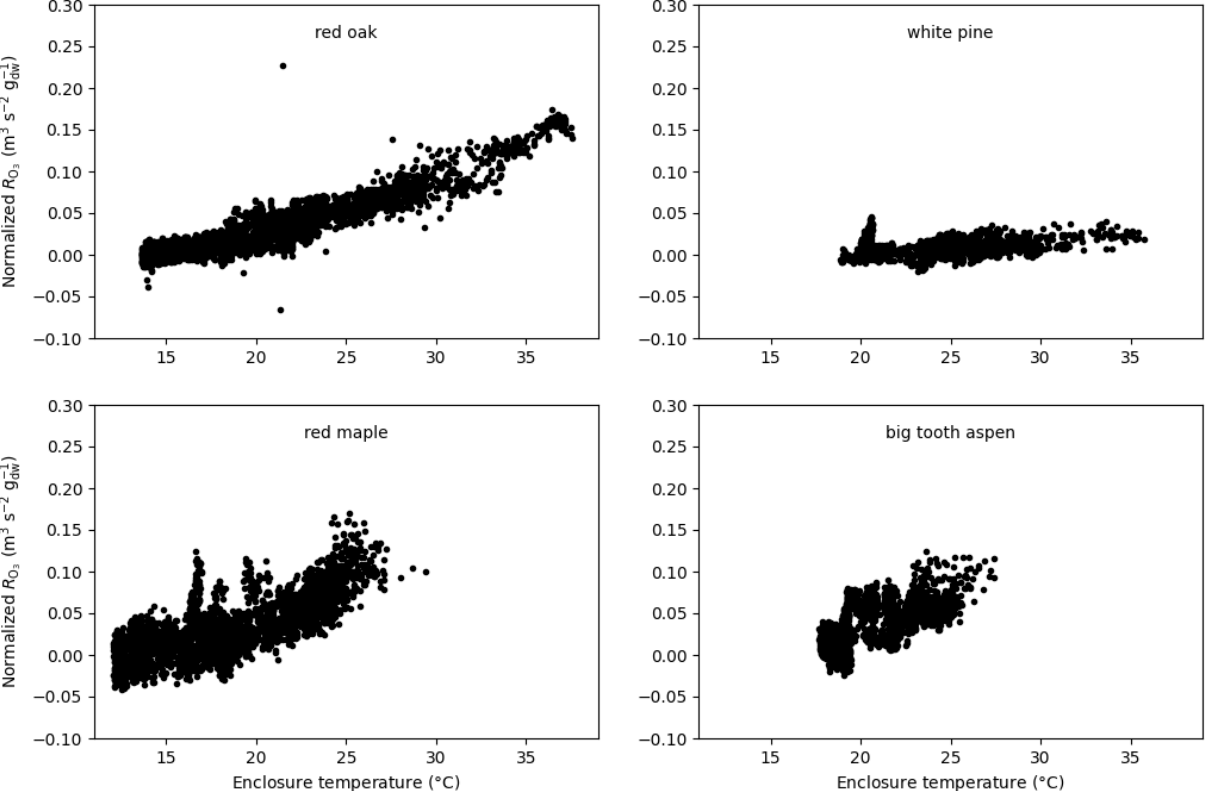
Figure 11. Total O 3 reactivity from the emissions results from experiments on red oak, red maple, white pine, and big tooth aspen at the University of Michigan Biological Station normalized to the amount of leaf dry mass and flow rate as a function of enclosure